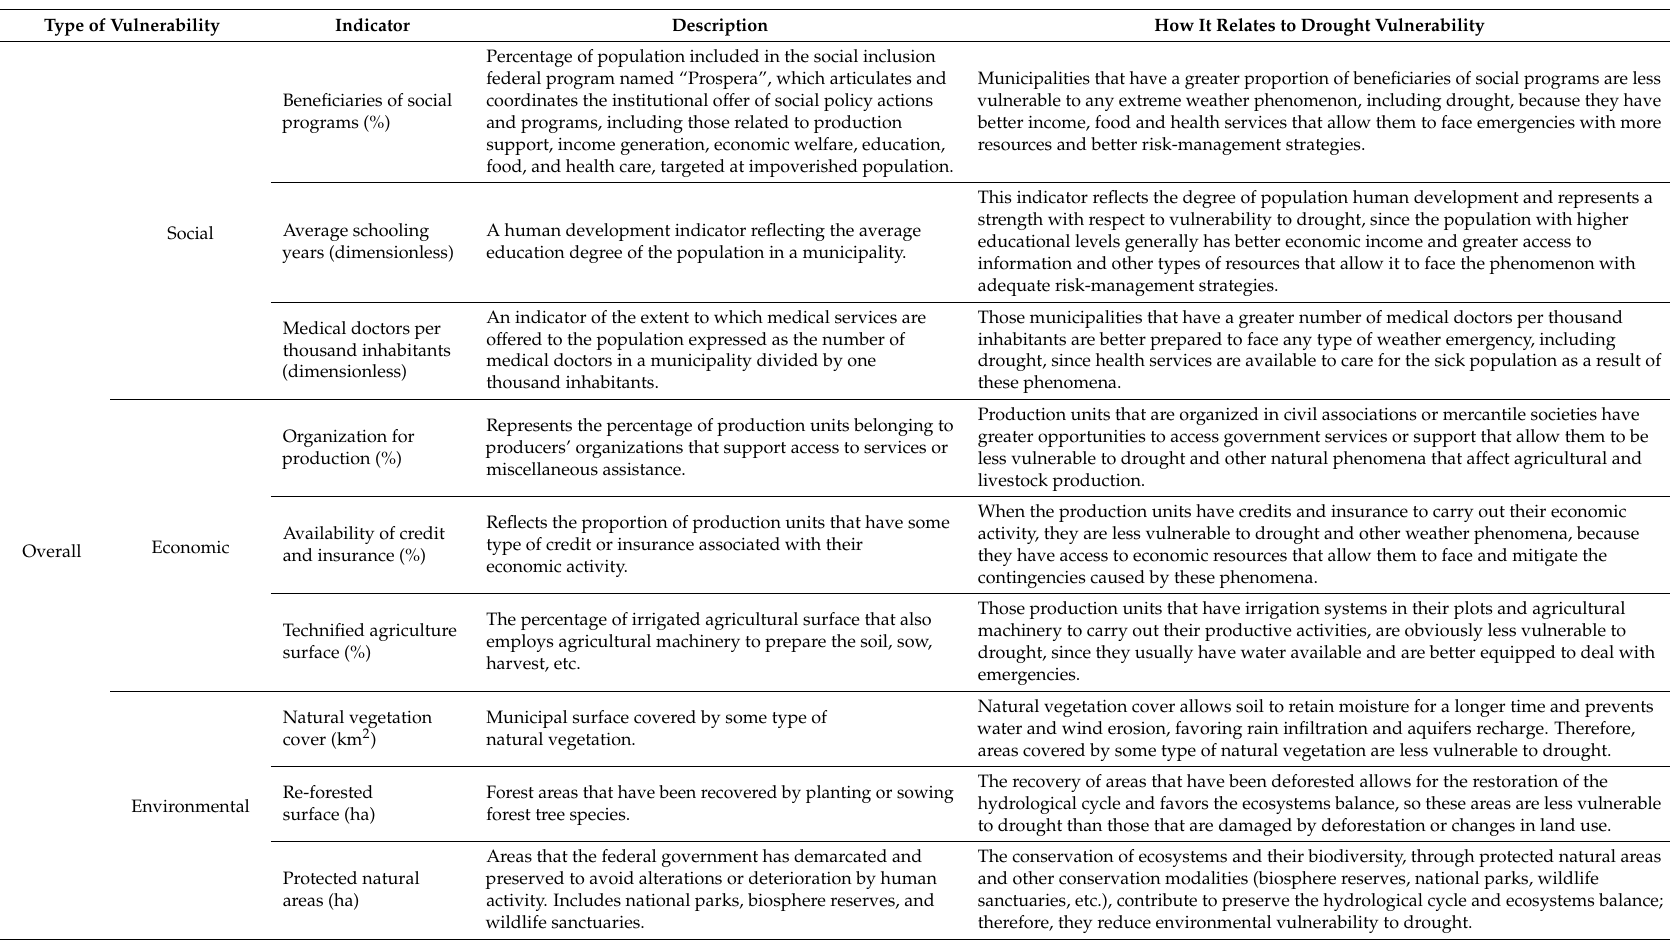
Table 4. Indicators of adaptive